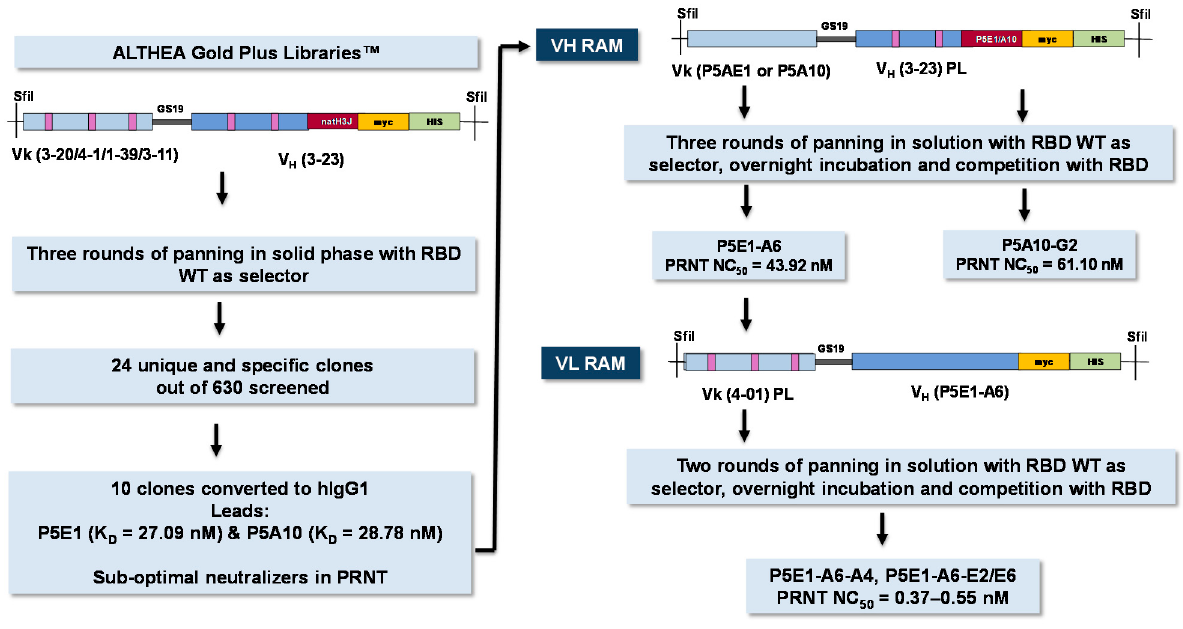
Figure 5. Stepwise strategy to isolate potent neutralizing antibodies from ALTHEA Gold Plus li- braries™.